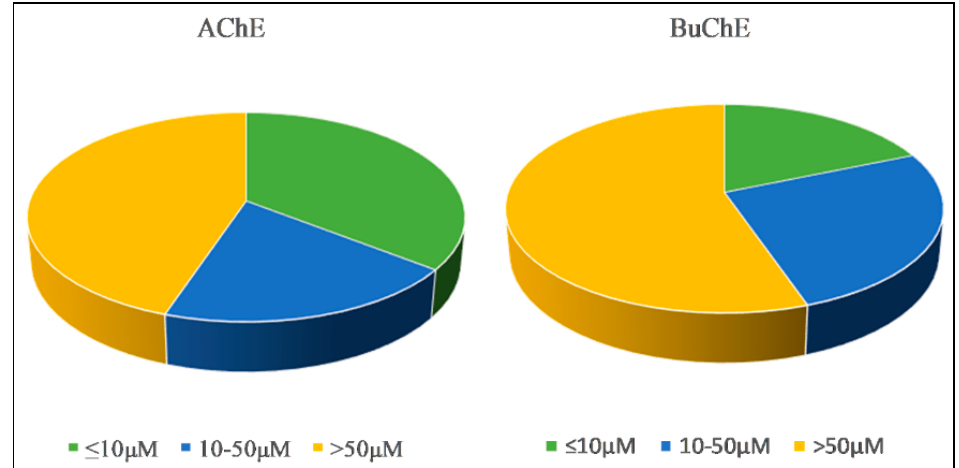
Figure 1. Cholinesterase enzyme inhibition of alkaloids (2011–2020).